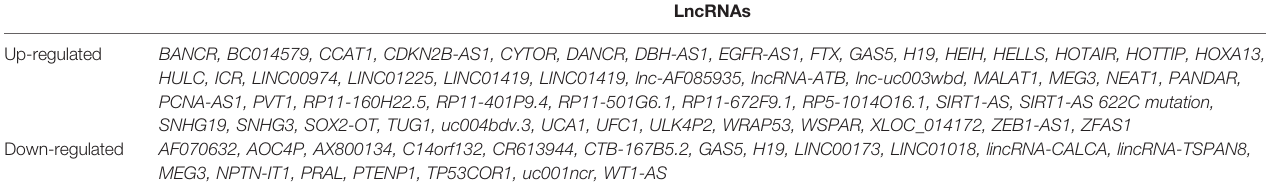
TABLE 1 | Human lncRNAs related to HCC